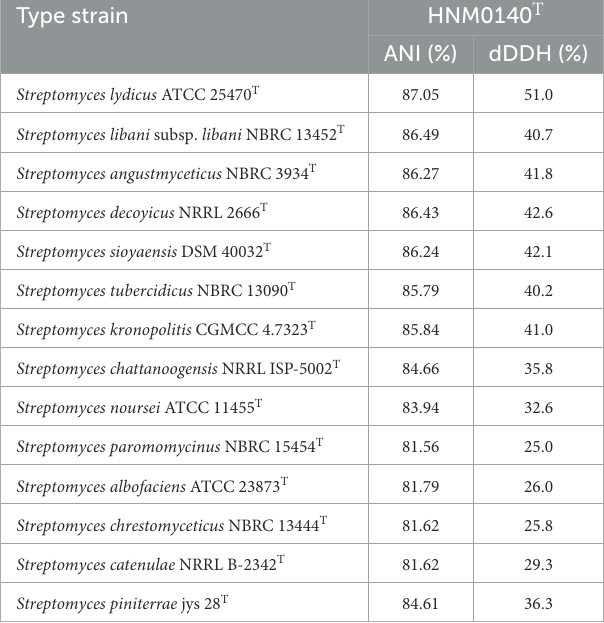
TABLE 3 Differential physiological characteristics between strain HNM0140 T and its closely related strains.